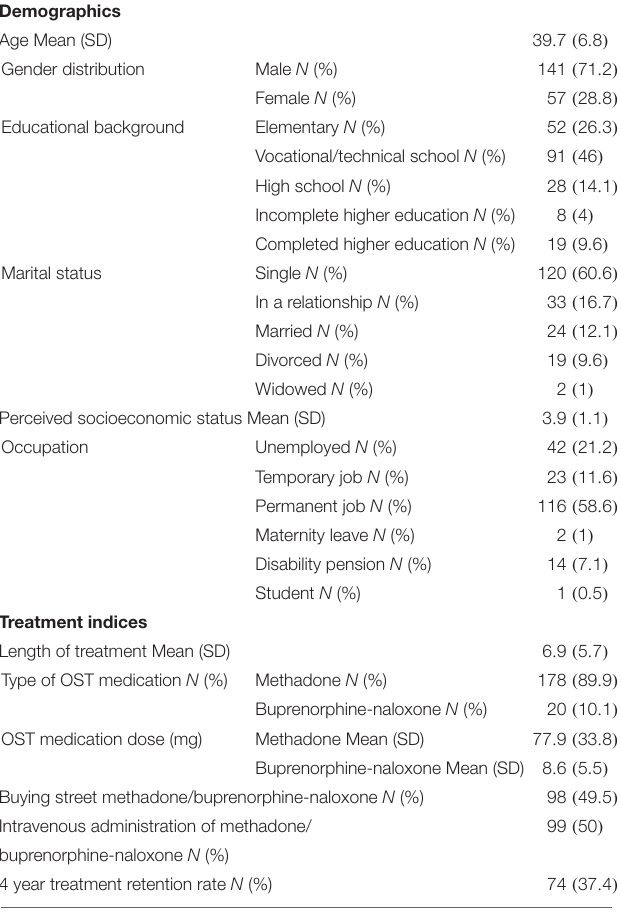
TABLE 1 | Demographics and treatment characteristics.